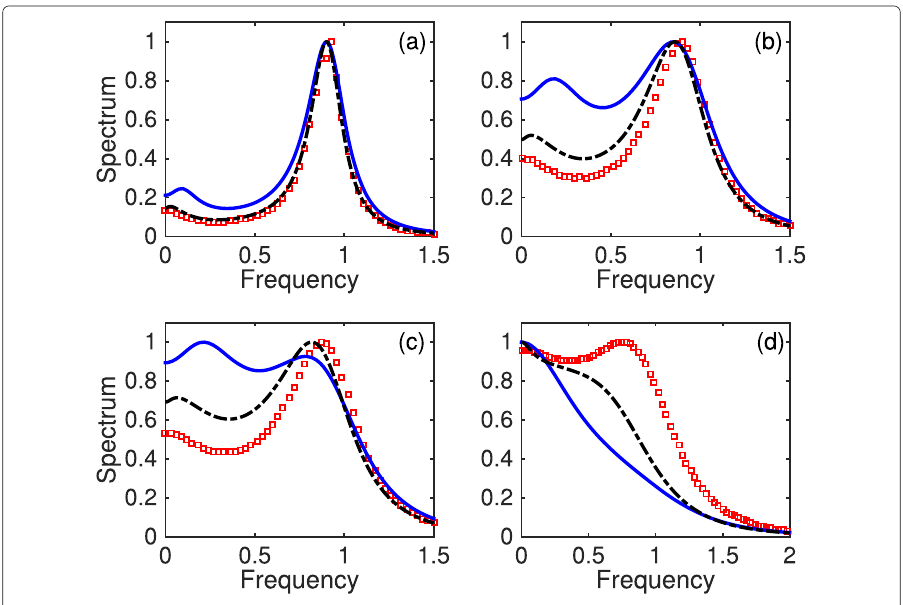
Fig. 6 Spectra of the coherent RBS, when ( a ) Kn = 0.02, ( b ) Kn = 0.04, ( c ) Kn = 0.05, and ( d ) Kn = 0.1. Solid and dashed lines are results from Dadzie’s equations (33) with κ m = 3 / 2 and κ m = 2 / 9,